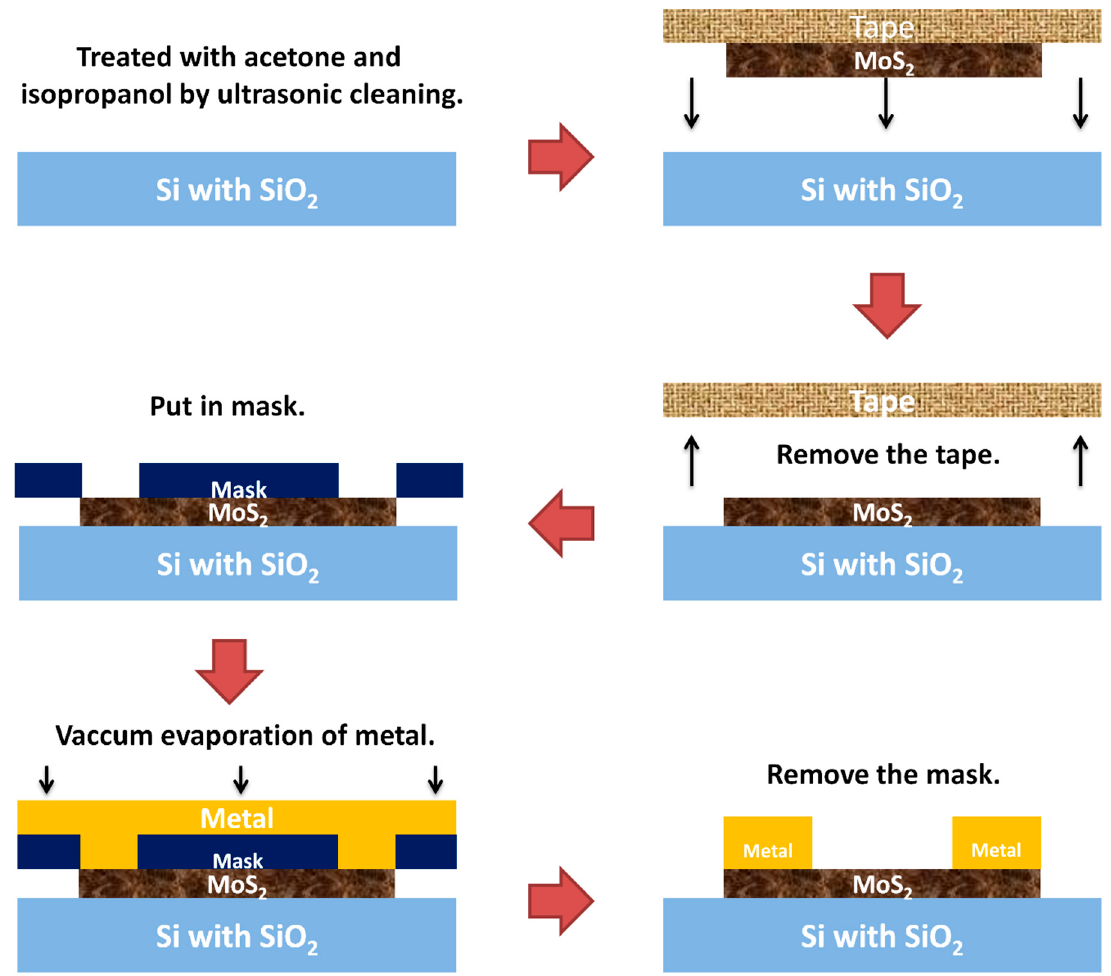
ff ect transistor (FET)